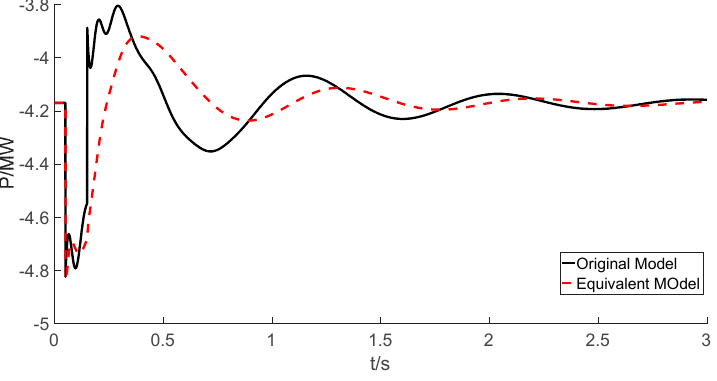
Figure 14. The response of the microgrid in Scenario 3.